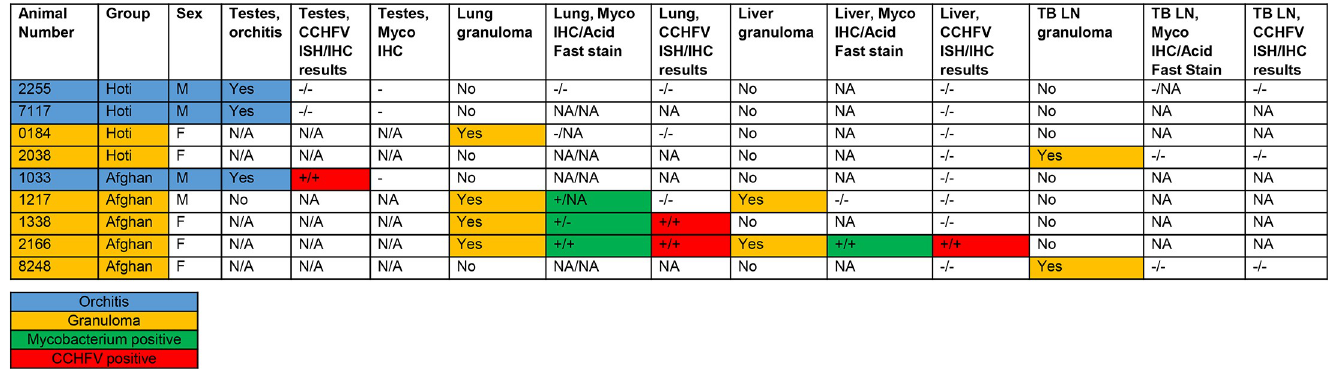
Fig 4. Summary of the histologic, ISH, IHC, and histochemical staining findings for select animals/tissues. Animals with orchitis are indicated by blue shading, the presence of granulomas by orange shading, mycobacterium positive tissues by green shading, and CCHFV RNA/antigen by red shading. N/A = not applicable and NA = not assessed.